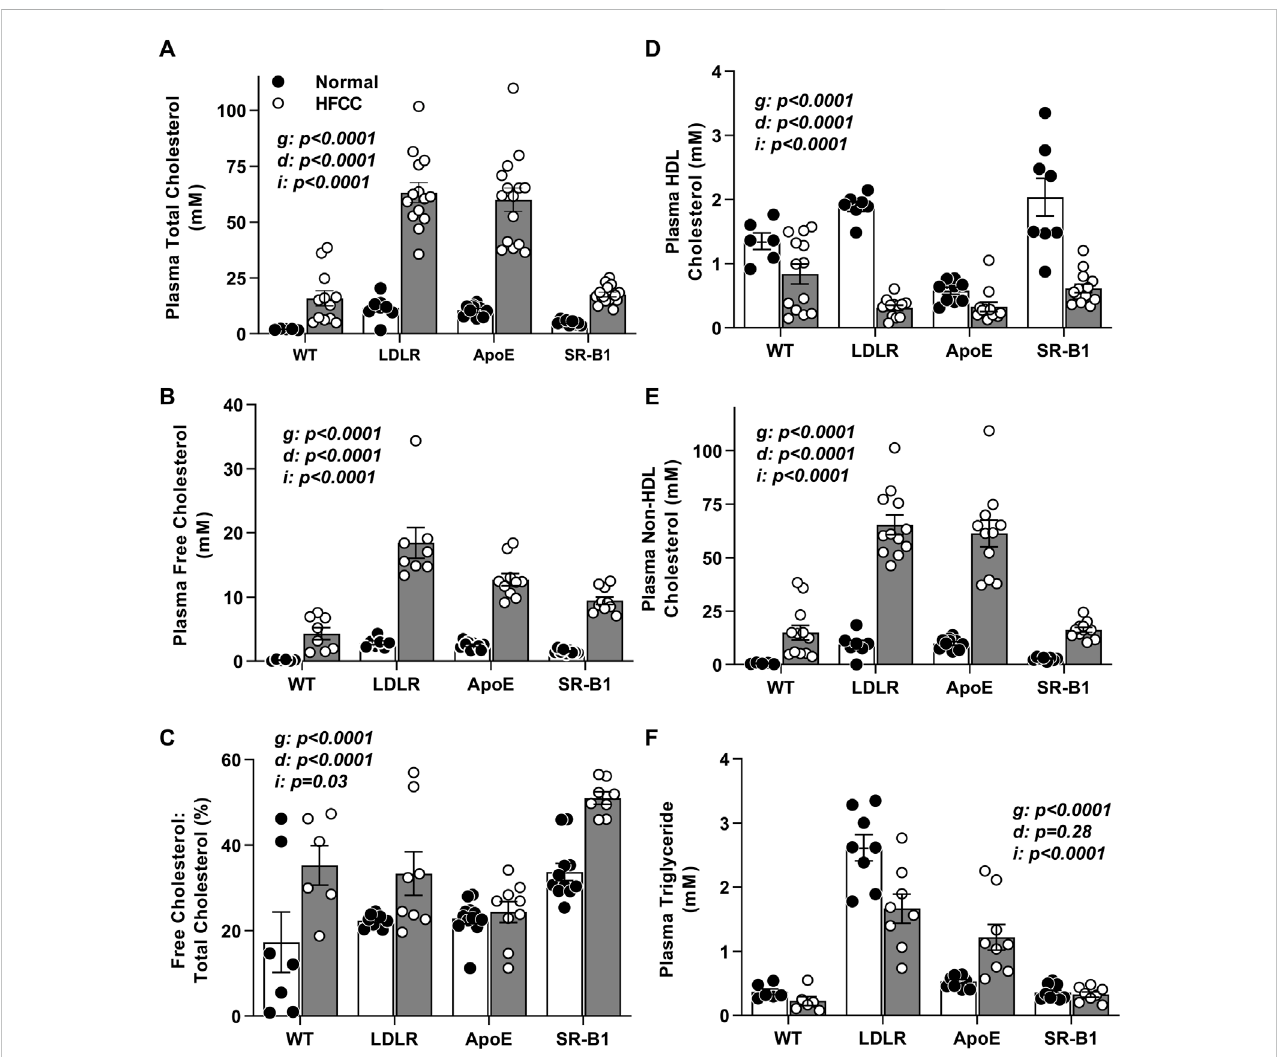
FIGURE 1 PlasmalipidparametersinHFCC-dietfedfemaleWT,LDLRKO,ApoEKO,andSR-B1KOmice.Bloodwascollectedafterfastingfrom10-weekoldfemale mice fed a normal diet (black symbols) or from mice fed the HFCC diet for 20 weeks beginning at 10 weeks of age (white symbols). Bars represent average plasmalipid levelsand symbolsrepresent datafromindividualWT( N =6 – 13),LDLR KO( N = 8 – 14),ApoEKO ( N =9 – 15), andSR-B1KO( N =8 – 15)micefor (A) total cholesterol, (B) unesteri fi ed (free) cholesterol, (C) free cholesterol: total cholesterol ratio, (D) HDL cholesterol, (E) non-HDL cholesterol, and (F) triglyceride.Errorbarsrepresentstandarderrorsofthemean.Statisticalsigni fi cancewasanalyzedbytwowayANOVA. p valuesareindicatedforthegenotype ( g ) and diet ( d ) variables and the interaction ( i ) between the effects of genotype and